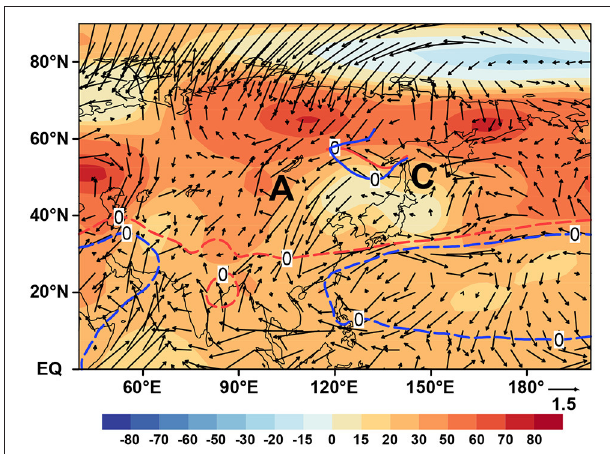
FIGURE 10 | Composite of atmospheric circulation of high- and low-index years (the difference of 500-hPa eddy geopotential height (shading, units: gpm) and the 850-hPa wind (vector, units: m s − 1 ) between high- and low-index years). Letters A and C represent anomalous low-level anticyclone and cyclone, respectively. The thick solid lines marked as 0 indicate the southern boundaries of NECV with the red line for high-index years and blue line for low-index years. Thick dashed lines are the same as solid lines except for denoting the WPSH